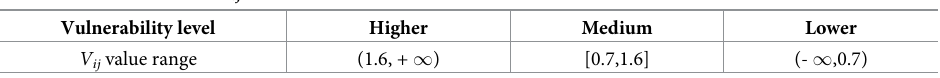
Table 2. Classification for V ij .